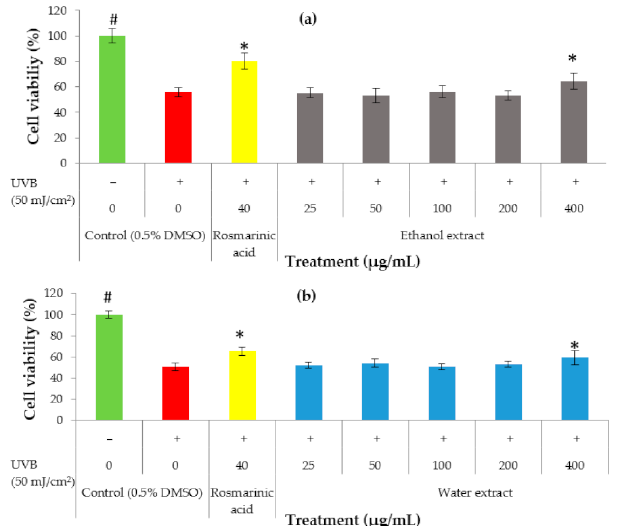
Figure 3. Protective effect of P. australis ethanol ( a ) and water ( b ) extracts against UVB-induced cytotoxicity in HaCaT keratinocytes. The HaCaT cells were exposed to UVB (50 mJ/cm 2 ) in the presence of algae extracts with various concentrations. The negative (0/+) and unexposed (0/ − ) controls were treated with 0.5% DMSO. Cell death was evaluated by an MTT test at 24 h in the HaCaT keratinocytes after UVB irradiation at a dose of 50 mJ/cm 2 except for the unexposed cells, which were covered with aluminum foil. The results are expressed as a percentage of cell survival with respect to 0/ − (untreated and unexposed). Data are expressed as the mean ± SD ( n > 3). * p < 0.05 (samples) and # p < 0.05 (unexposed control) represent significant differences from the group exposed to UVB